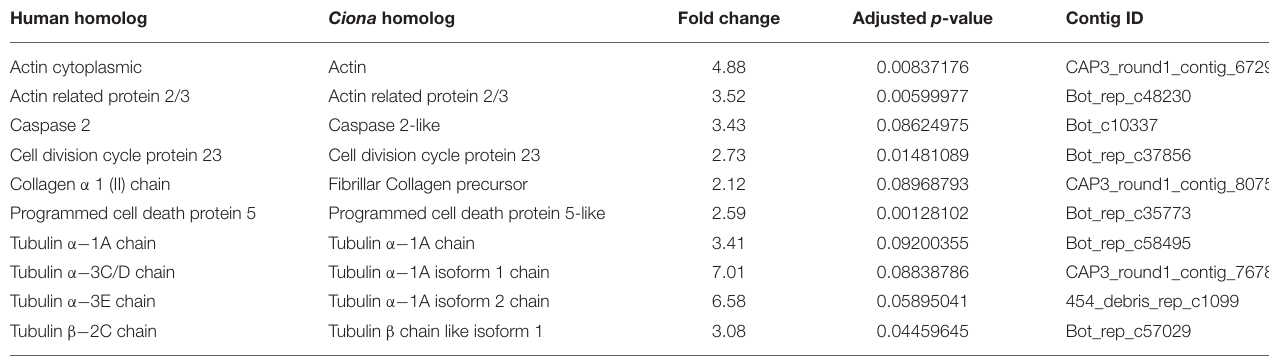
TABLE 2 | Top ten differentially expressed genes not involved in fertility. Human